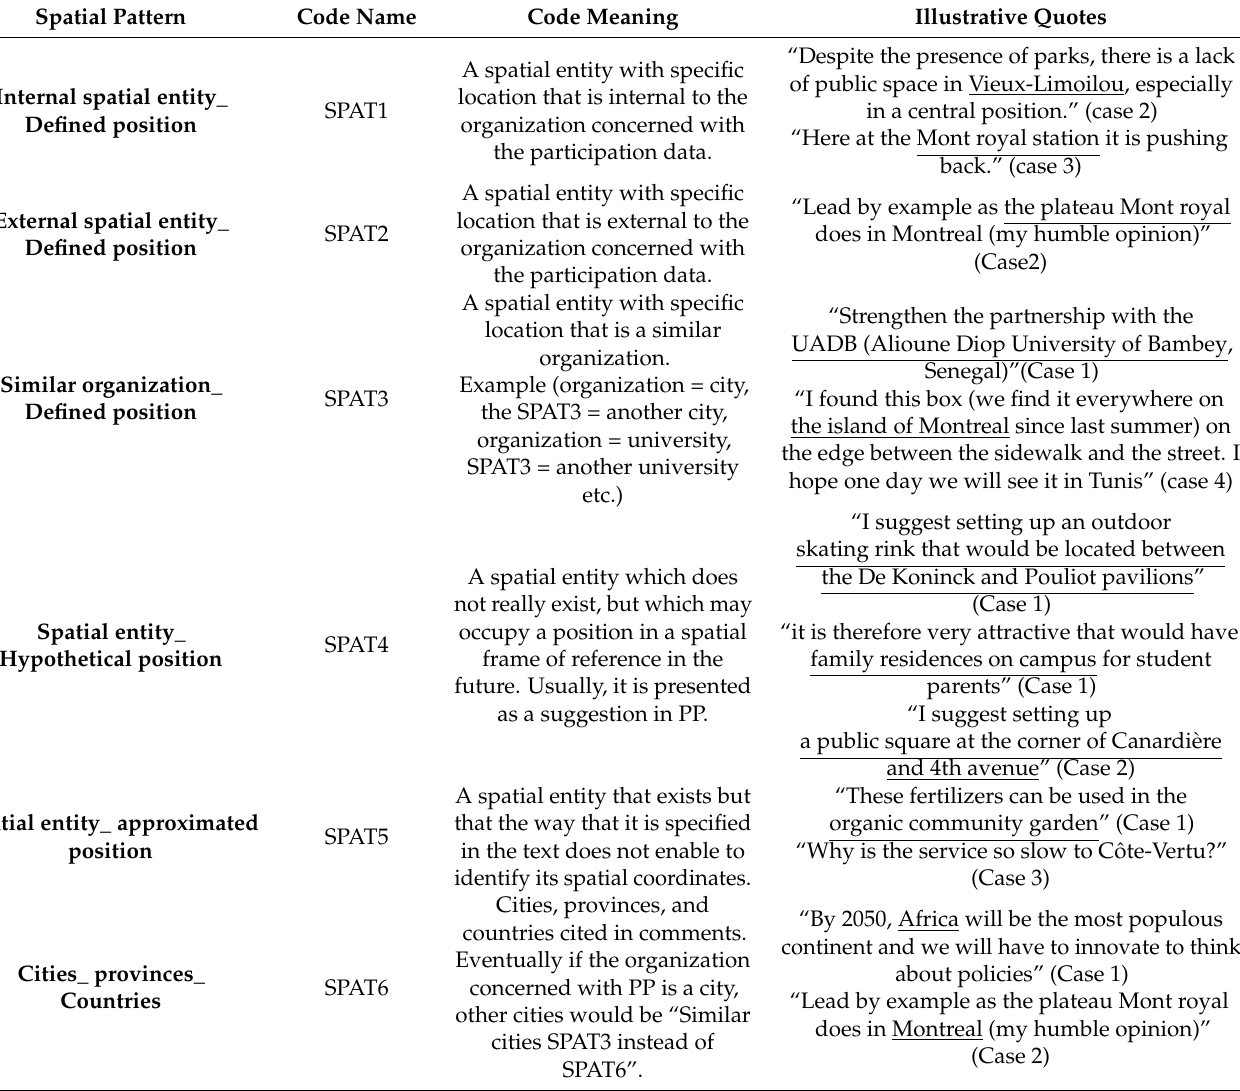
Table A4. Spatial patterns in both online and offline SP data.